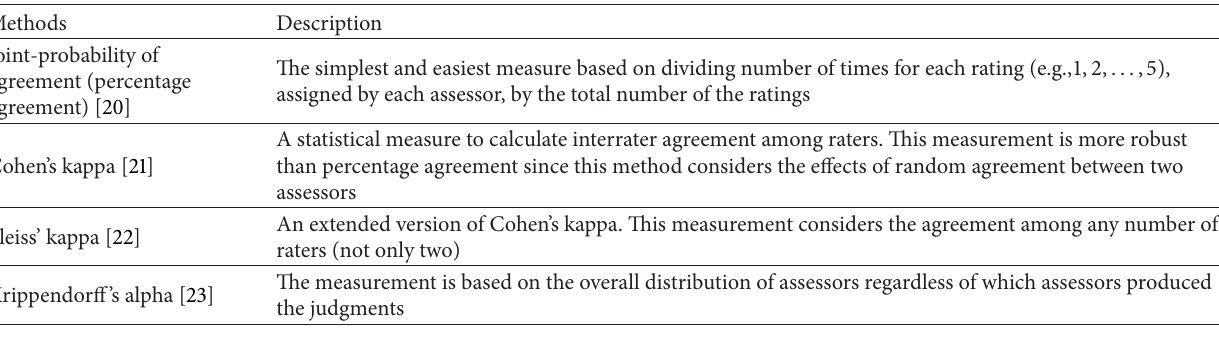
Table 3: Statistics for calculating the interrater